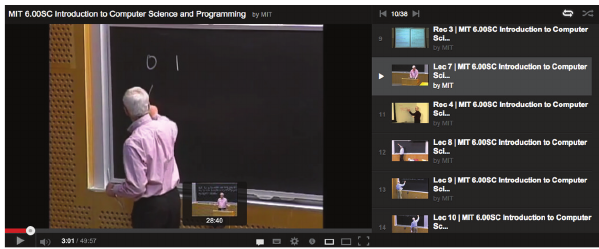
Figure 1: Google YouTube provides several thumbnails for each video. Moreover, a thumbnail is used to represent related videos on the right. The selection (as well as the number) of these thumbnails is important for effective user